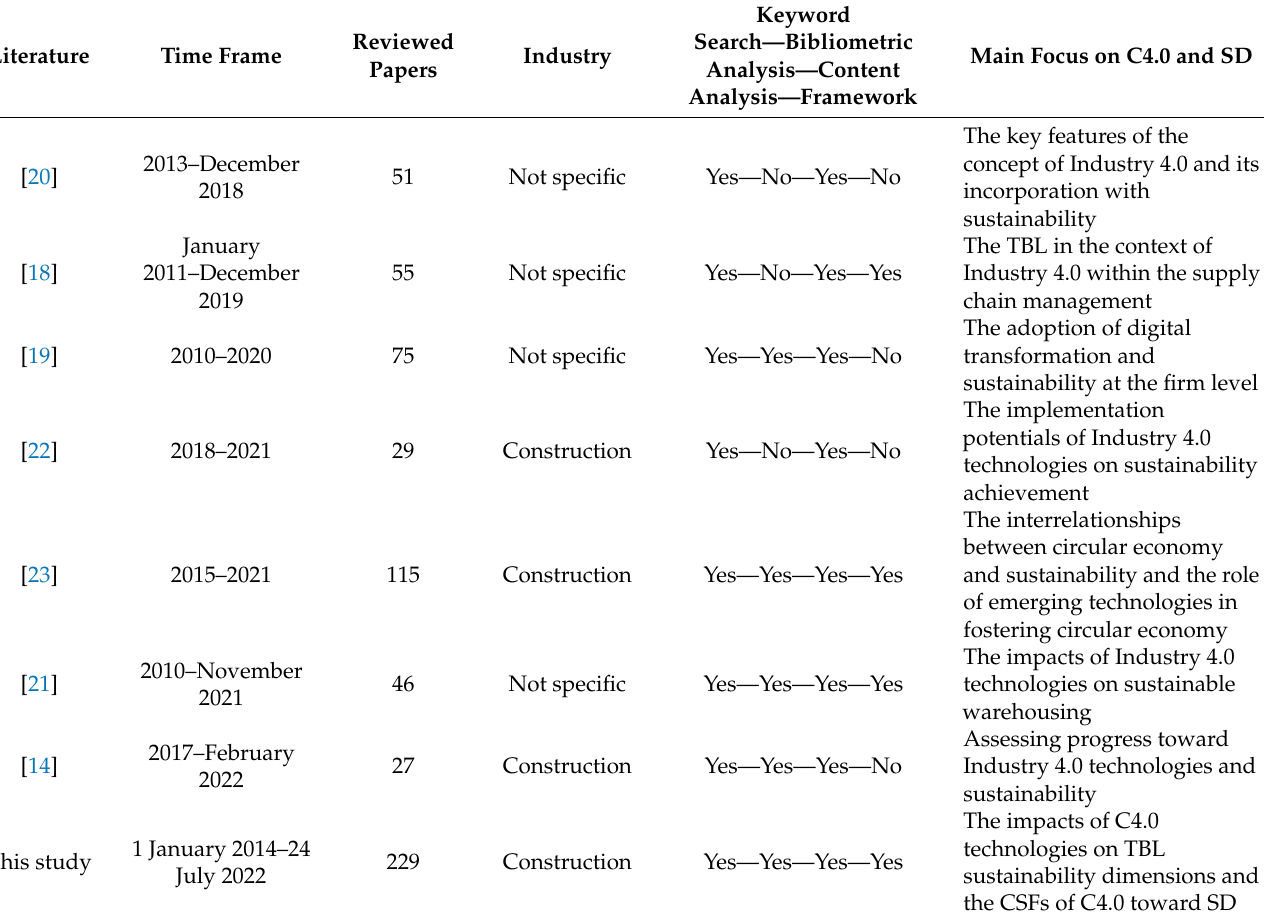
Table 1. Comparison of related literature